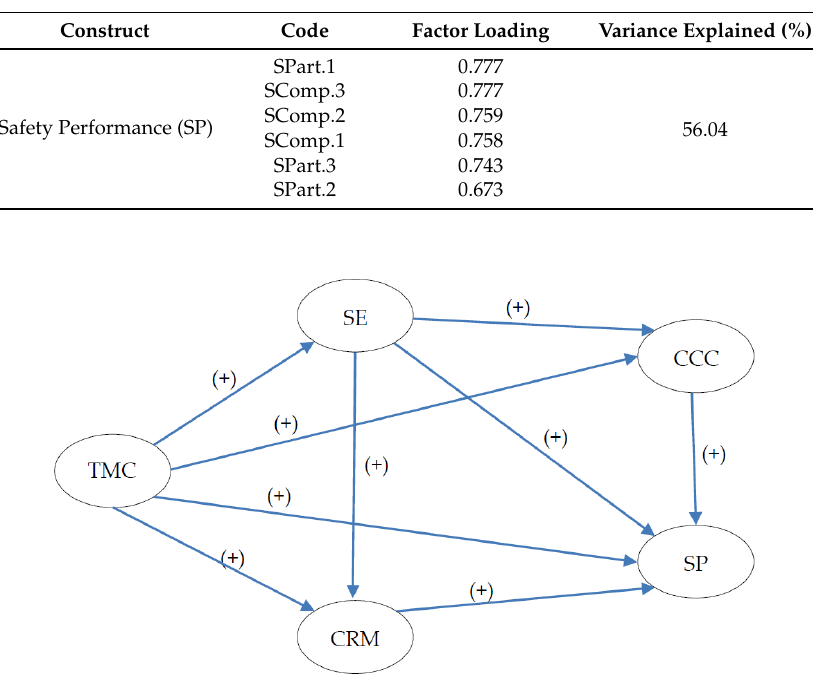
Table 2. Exploratory factor analysis of safety performance.